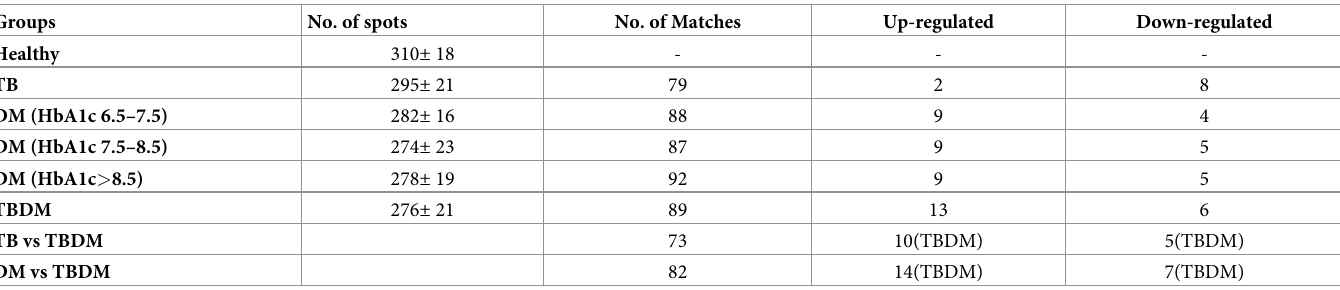
Table 3. Comparative computational analysis of 2DE-PAGE data of human PBMCs proteome among different groups using ImageMaster software. Groups No. of spots No. of Matches Up-regulated Down-regulated Healthy 310 ± 18 - - - TB 295 ± 21 79 2 8 DM (HbA1c 6.5–7.5) 282 ± 16 DM (HbA1c 7.5–8.5) DM (HbA1c > 8.5) TBDM 276 ± 21 89 13 6 TB vs TBDM 73 10(TBDM) 5(TBDM) DM vs TBDM 82 14(TBDM)